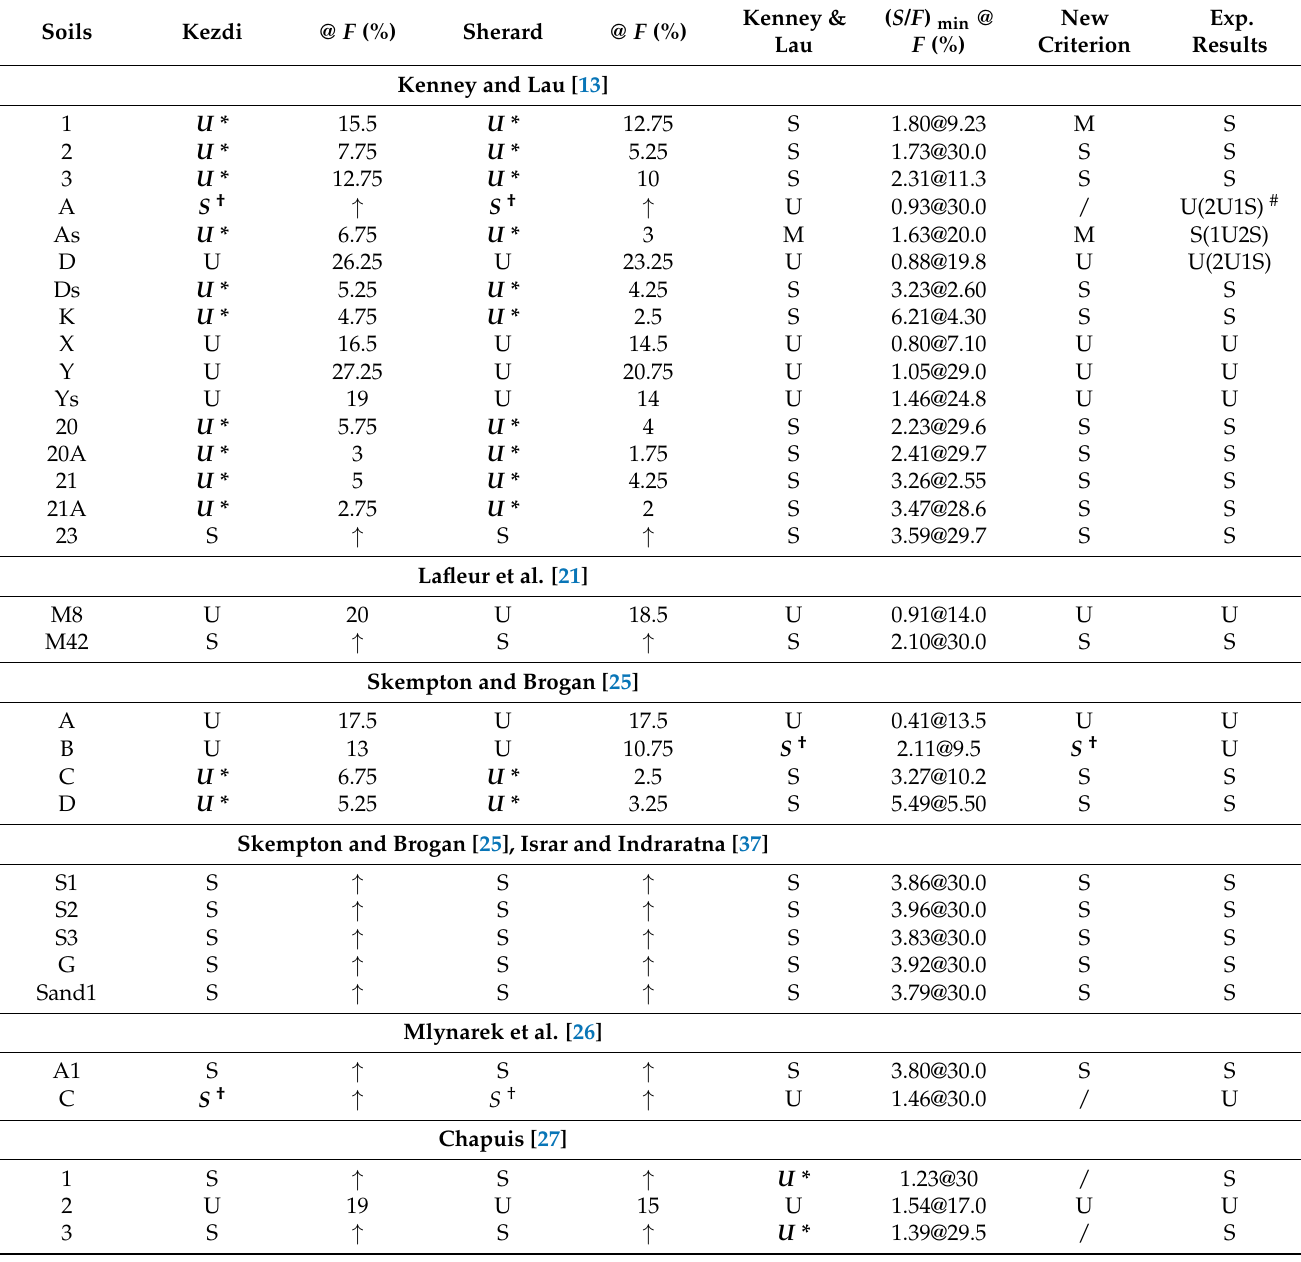
Table 1. Internal stability evaluation of sand–gravel